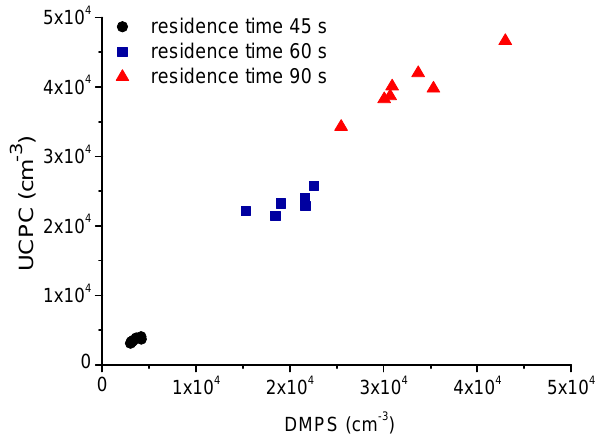
Figure 5. The variation in the median particle diameters at different H 2 SO 4 concentrations at T = 283K, with the RH set at 30% and a residence time of